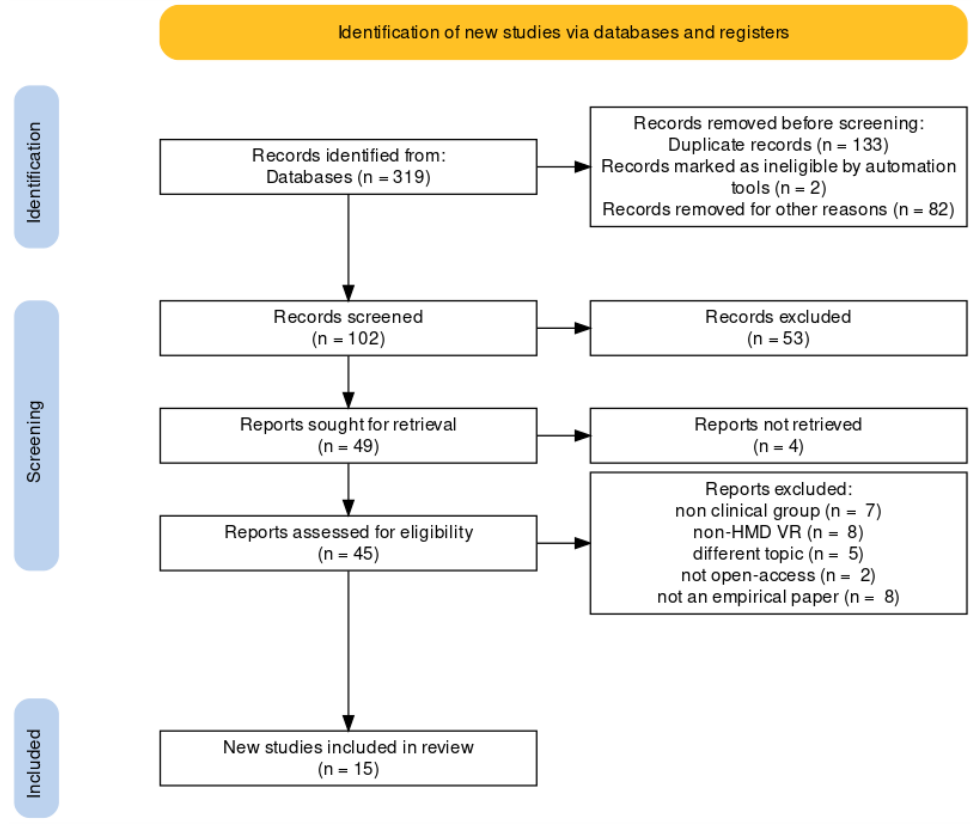
Figure 2. Overview of the screening and paper selection process (PRISMA flowchart).